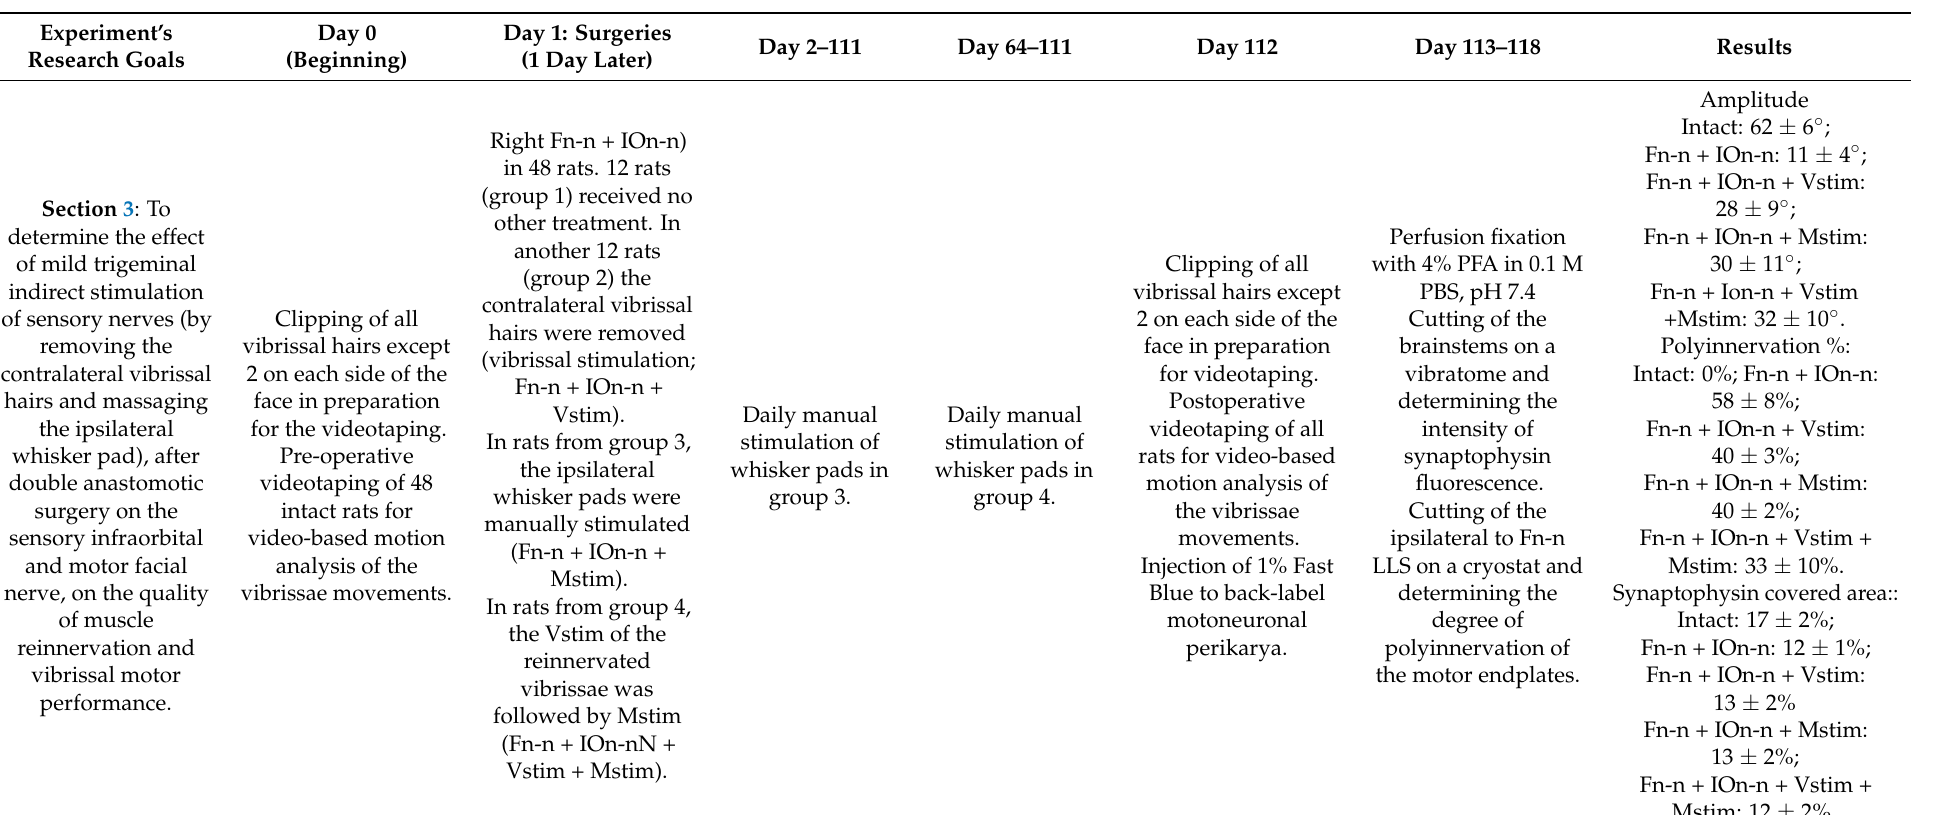
Table 3. Experimental design flow chart depicting animal grouping and sequence of the main procedures in the section describing the effect of mild ipsilateral to Fn-n trigeminal indirect stimulation and direct trigeminal stimulation after double anastomotic surgery on the sensory infraorbital and motor facial nerves.. Fn-n, transection and suture of the facial nerve; Ion-ipsi-ex, excision of the ipsilateral infraorbital nerve; Mstim, manual stimulation; Fn-n + IOn-n + Vstim, facial nerve transection and suture + infraorbital nerve transection and suture + vibrissal